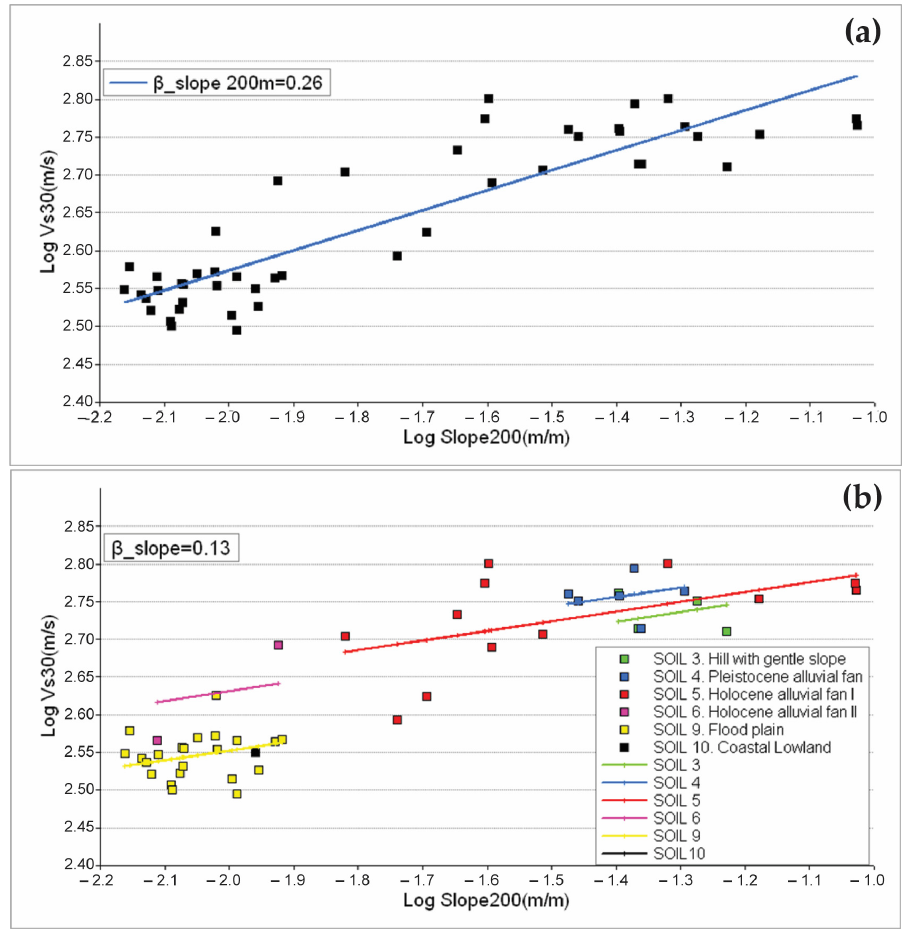
Figure 13. Correlation between calculated V s30 values and slope: ( a ) using only those variables (MD2); and ( b ) considering indicator variables for the geological units (MD3).